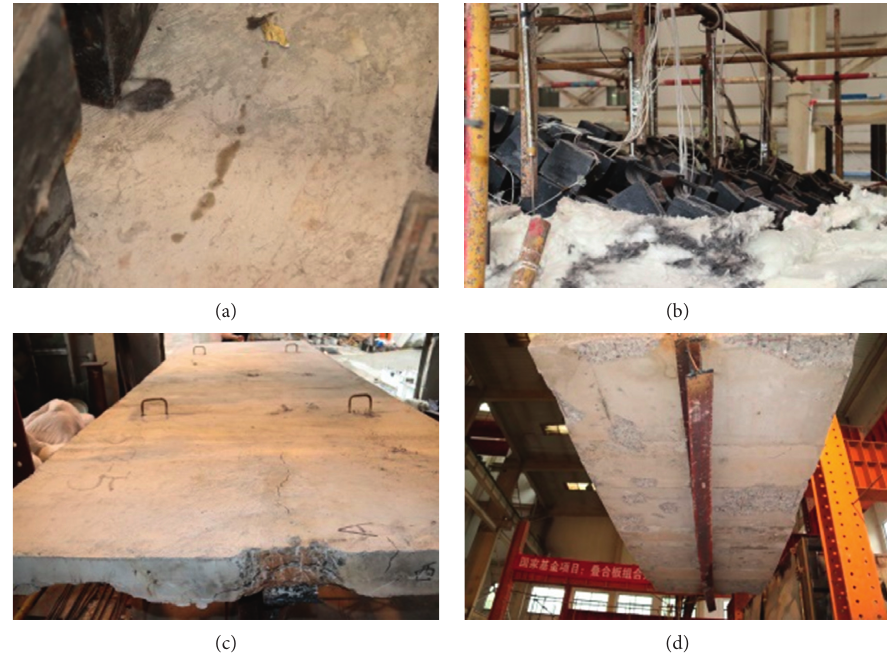
Figure 7: Failure modes of SCB-2: (a) water spots, (b) severe out-of-plane instability of the slab, (c) cracks on the top surface of the slab, and (d) local bursts on the bottom surface of the